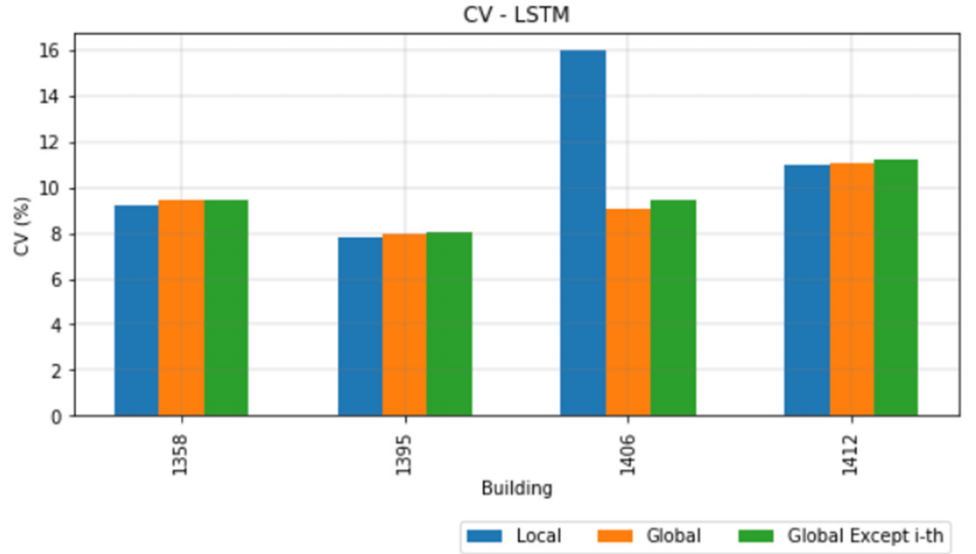
Figure 19. Comparison between the CV on test set obtained using LSTM method with different modalities: local, global and global trained using all the available data except the energy consumption related to the selected